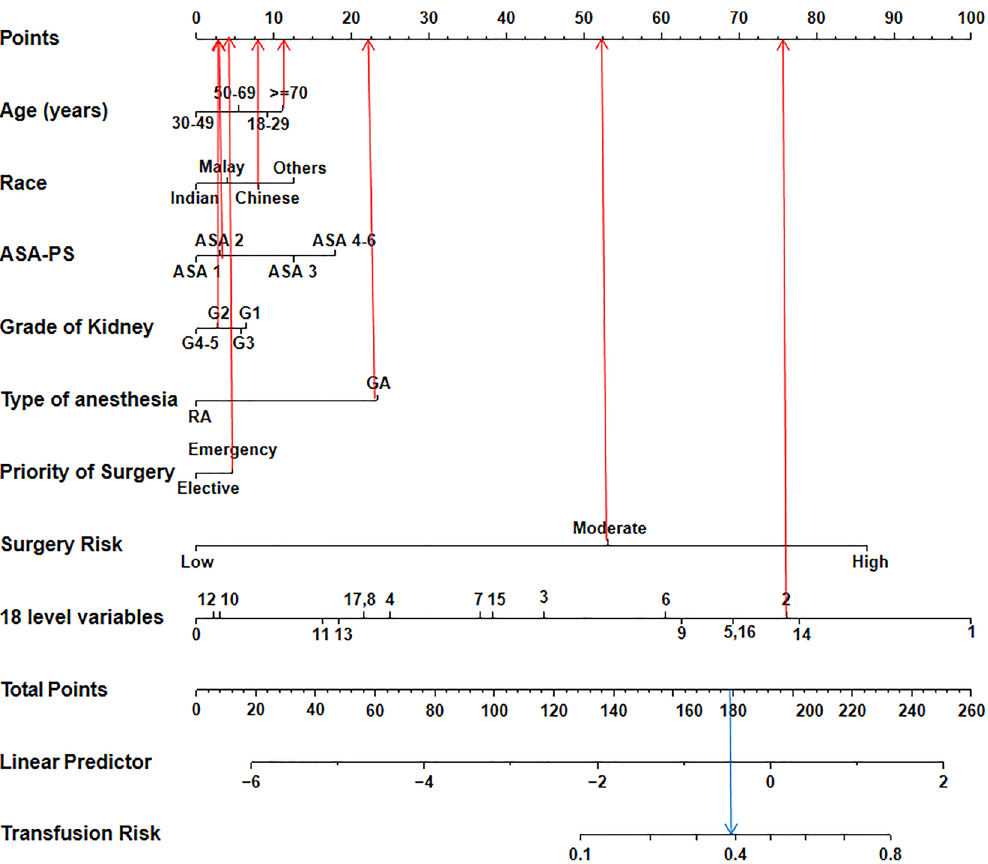
Figure 2. Nomogram estimating transfusion risk in surgery